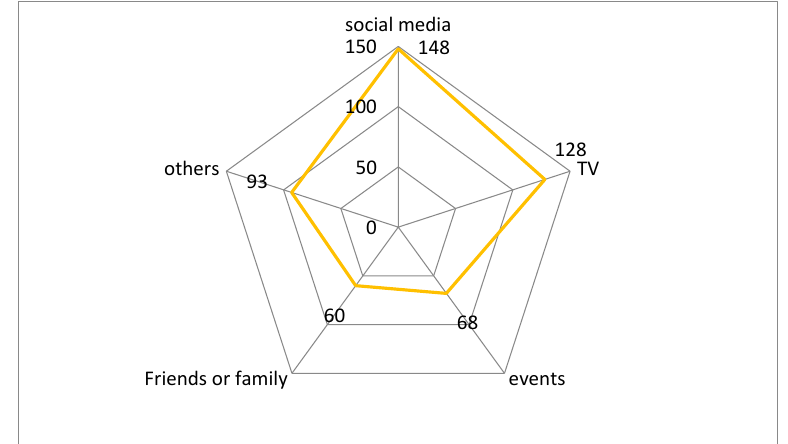
Fig. 3: Tools used by respondent’s for GW information